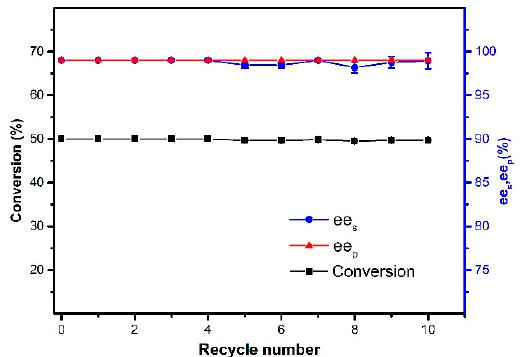
Figure 12. The reusability of magnetic CALB CLEAs. Reactions performed with 25 mg magnetic CALB CLEAs and 2 mL of n-hexane containing 0.2 mmol of 1-phenylethanol and 0.4 mmol of vinyl acetate at 50 °C for 48 h.